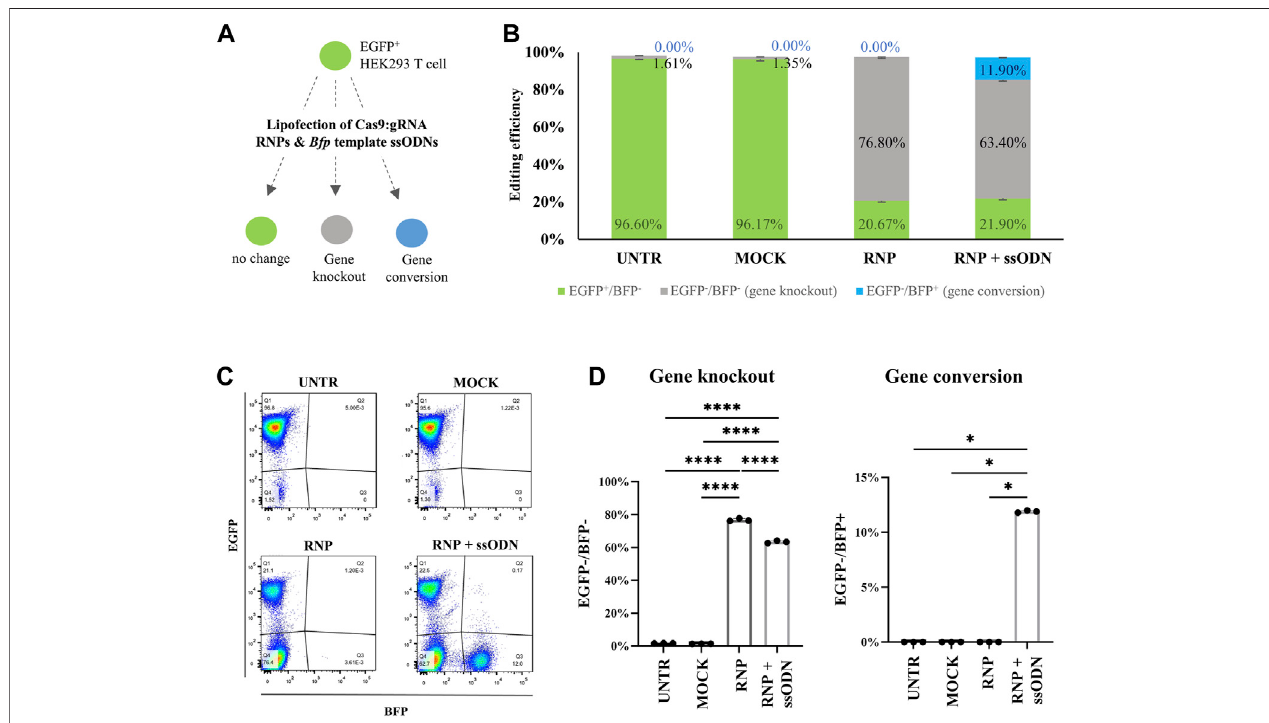
FIGURE 1 | Evaluation of gene editing in HEK293T cells by fl ow cytometry. (A) Cas9:gRNA RNP (10 nM) and Bfp template ssODN (42 nM) were lipofected in EGFP-HEK293Tcellstotestgeneknockout(EGFP − /BFP − )andgeneconversion(EGFP − /BFP + ). (B) Geneknockout(EGFP − /BFP − ,greybars),geneconversion(EGFP − / BFP + , blue bars) and unaffected cells (EGFP + /BFP − , green bars) in the HEK293T cell experiment. (C) Representative EGFP/BFP dot plots 10 days after transfection. Lipofecting RNP alone stimulated a solid gene knockout (EGFP − /BFP − ) population (RNP). Co-lipofecting RNP and ssODN (RNP + ssODN) induced both, gene knockoutandgeneconversion(EGFP − /BFP + ).TheUNTRandMOCKcontrolremainedunaffected(EGFP + /BFP − ). (D) Geneknockout(EGFP − /BFP − )percentageinRNP was signi fi cantly higher compared with RNP + ssODN, UNTR and MOCK. Statistical signi fi cance was determined using a one-way ANOVA, followed by a multiple comparison Turkey´s test. Gene conversion (EGFP − /BFP + ) was detected after RNP and ssODN (RNP + ssODN) co-lipofection and completely absent in the UNTR, MOCK and RNP controls. Statistical evaluation was performed using a Kruskal-Wallis test followed by a multiple comparison Dunn´s test. UNTR: negative control; MOCK: unloaded RNAiMAX; RNP: RNAiMAX loaded with RNP; RNP + ssODN: RNAiMAX loaded with RNP and ssODN. * p < 0.05; **** p < 0.0001. n = 3 technical